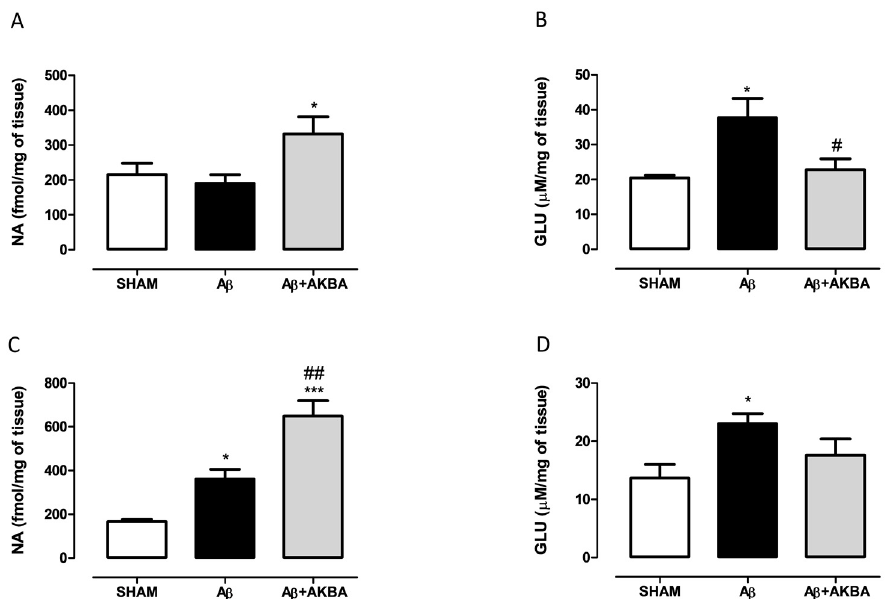
Figure 4. Effects of AKBA administration on NA and GLU content in PFC and HIPP of A β -treated mice. ( A ) NA (fmol/mg of tissue, SHAM n = 8, A β n = 6, A β +AKBA n = 6) and ( B ) GLU (uM/mg of tissue, SHAM n = 5, A β n = 5, A β +AKBA n = 6) levels in the PFC of mice 7 days after icv injection of vehicle (SHAM, 5 µ L, white bar), A β (A β , 4 µ M, black bar), and A β +AKBA (A β , 4 µ M + sublingual AKBA, 5 mg/kg, gray bar). ( C ) NA ( fmol/mg of tissue, SHAM n = 6, A β n = 6, A β +AKBA n = 6) and ( D ) GLU (uM/mg of tissue, SHAM n = 6, A β n = 6, A β +AKBA n = 5) levels in the HIPP of mice 7 days after icv injection of vehicle (SHAM, 5 µ L, white bar), A β (A β , 4 µ M, black bar), and A β +AKBA (A β , 4 µ M + sublingual AKBA, 5 mg/kg, gray bar). One-way ANOVA followed by Tukey’s multiple comparison test, * p < 0.05 A β versus SHAM; * p < 0.05, *** p < 0.001 A β +AKBA versus SHAM; # p < 0.05, ## p < 0.01 A β +AKBA versus A β .